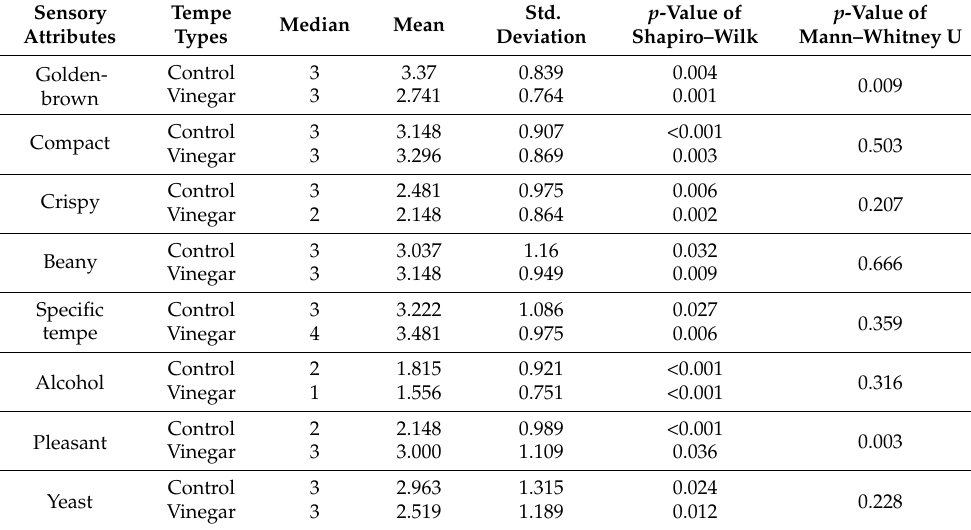
Table 2. Descriptive statistics of sensory attributes in RATA